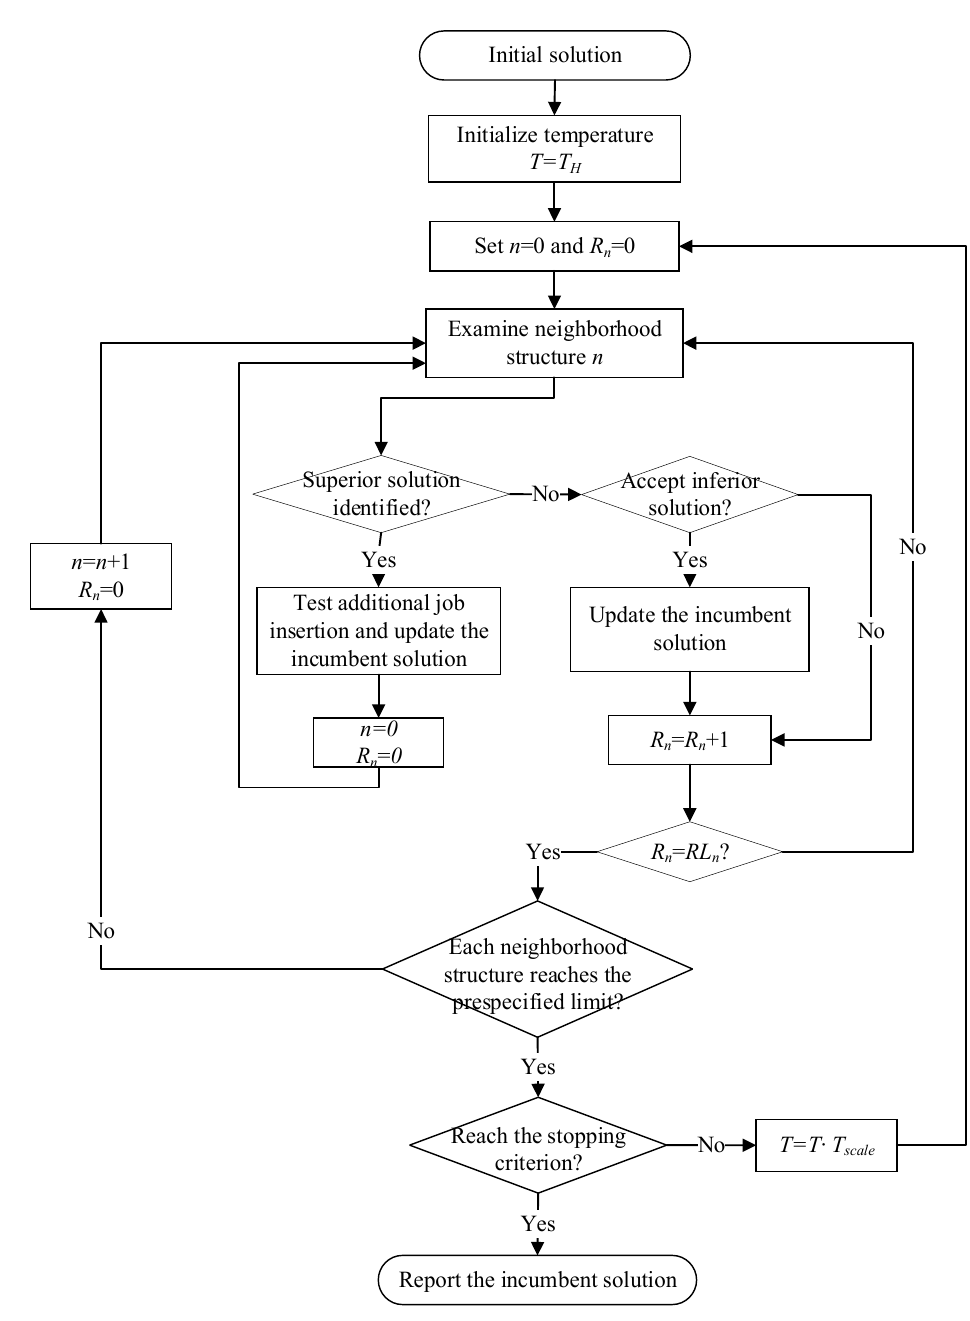
Figure 2. Algorithmic steps of the population-based simulated annealing (PBSA) approach. Figure 5. Algorithmic steps of the population-based simulated annealing (PBSA)